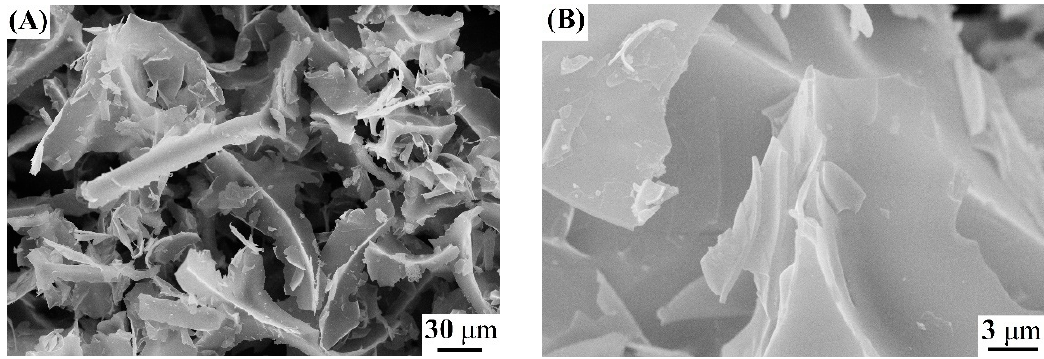
Figure 2. SEM images of sample 1 ( A , B ).